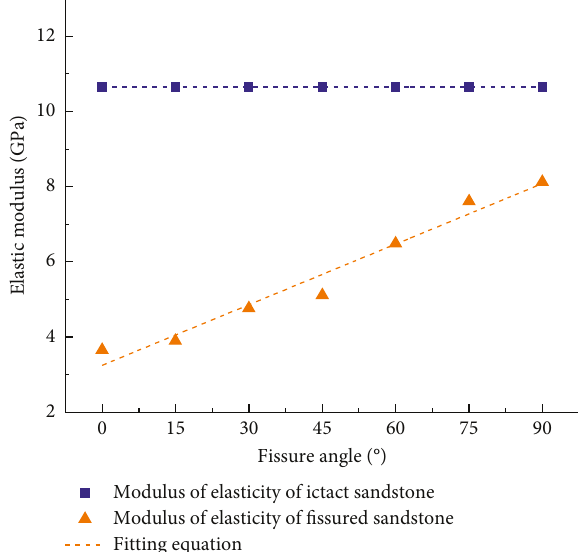
Figure 5: Relationship between the elastic modulus of the fissured sandstone and the fissure